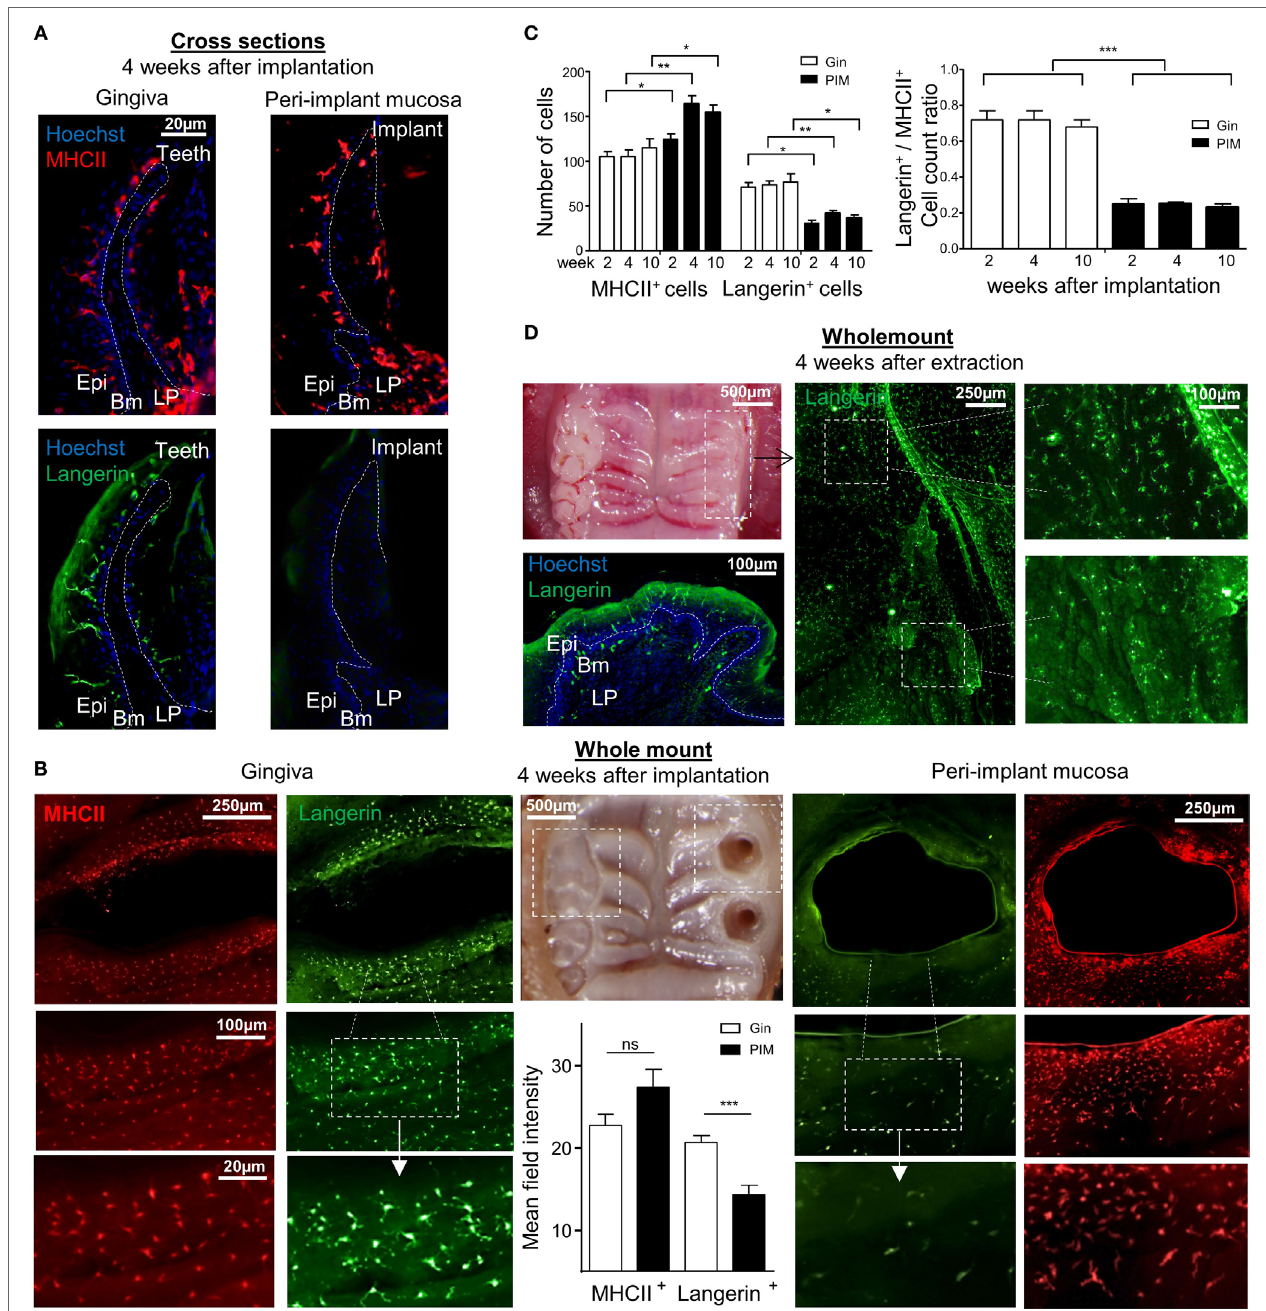
FigUre 3 | Visualization of langerin and MHCII expression in the peri-implant mucosa. (a) Immunofluorescence imaging of the peri-implant and gingival cross sections tissues prepared 4 weeks after implantation stained against MHCII (red), langerin (green), and hoechst (blue) for nuclear visualization. Representative immunofluorescence images of two independent experiments are shown. In each experiment, at least three mice were examined. (B) Epithelial layers prepared from peri-implant and gingival tissues 4 weeks after implant insertion, stained for (red), langerin (green), and hoechst (blue). Whole mount immunofluorescence images from one out of two independent experiments are shown, at least three mice were examined in each experiment. Bar graphs represent the mean field staining intensity of langerin and MHCII in the epithelium, shown as the mean ± SEM. The average pixel intensity was calculated for each tissue using ImageJ software by 100 µm circumferential countering the epithelium around implant and teeth ( n = 3 mice per group). Representative images of one out of two independent experiments are shown. (c) Graphs presents the total numbers of MHCII-positive or langerin-positive cells per a field of view, as well as the relative ratio of the noted cells in epithelial sheets taken 2, 4, and 10 weeks after implant insertion, presented as the mean ± SEM ( n = 6 mice per time points). Data of one out of two independent experiments are presented. (D) Four weeks after tooth extraction, epithelial tissues were removed from the alveolar process and subjected to immunofluorescence staining as described above. Representative images of one out of two independent experiments are provided, three mice were analyzed in each experiment. * p < 0.05, ** p < 0.01, *** p <